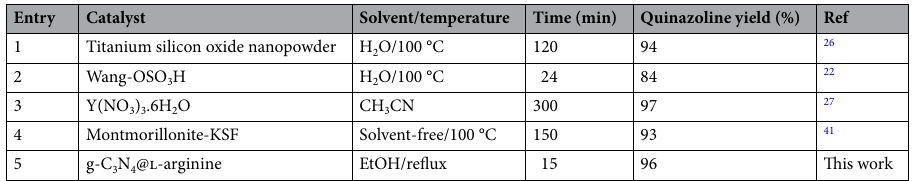
Table 7. Comparison of catalytic activity of g-C 3 N 4 @l-arginine with other reported catalysts for the synthesis of 2,3-dihydro quinazoline derivatives . Reaction condition: 4-chlorobenzaldehyde (1mmol), isotonic